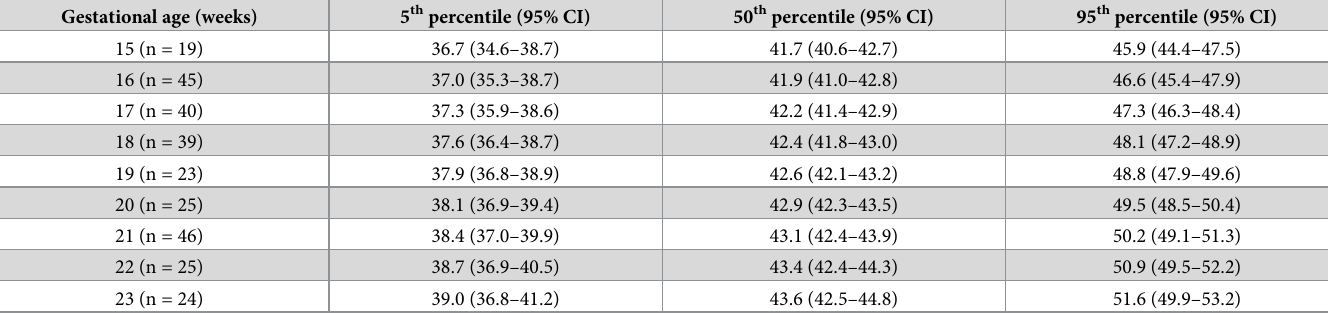
Table 3. Reference range of jaw index as estimated by the quantile regression analysis with 95% confidence interval along gestational age (N =